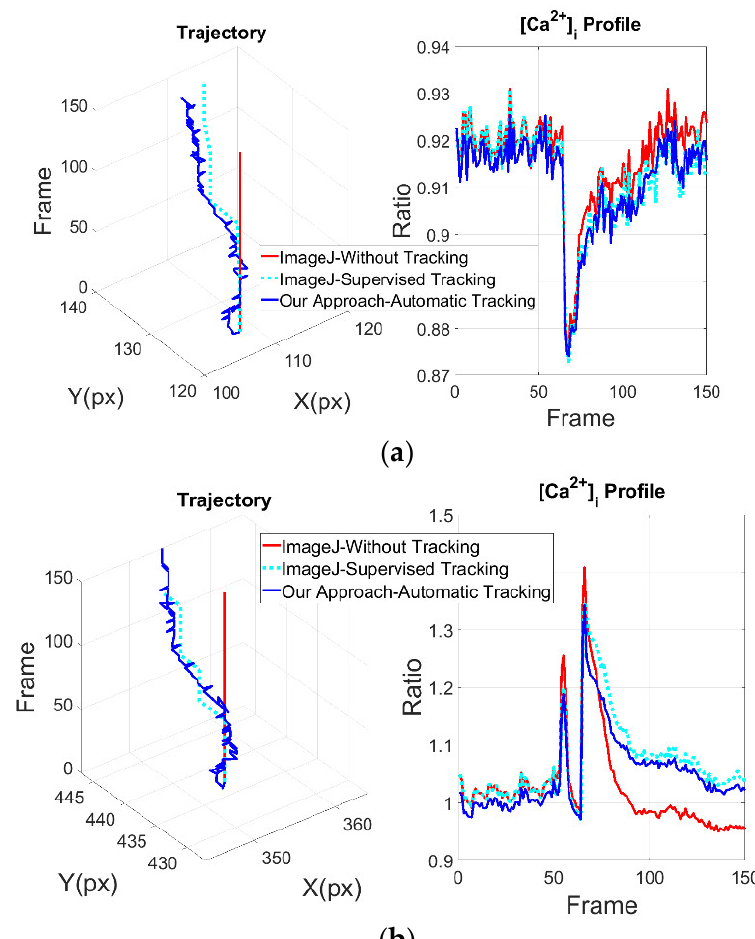
Figure 4. Results per defined zones due to mechanical stimuli: ( a ) Results obtained from zones 1 and 3; ( b ) Results obtained from zone 2. ( Left ), shows trajectories of cells, i.e., calculated position on X and Y axes respectively, measured in pixels (px). ( Right ), shows typical recordings of CP analyzed by: ImageJ without tracking (red line); with manually tracking (cyan line) and automated tracking proposed system (blue line).